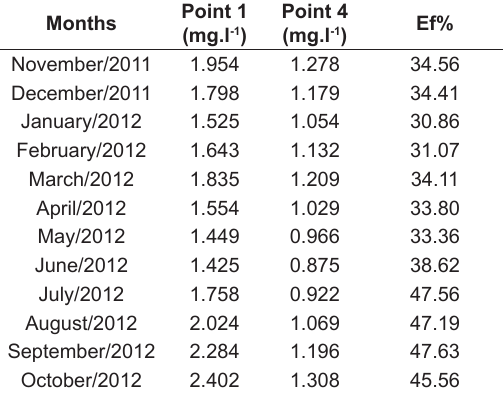
Table 2. Efficiency retention of total nitrogen in 1 and 4.